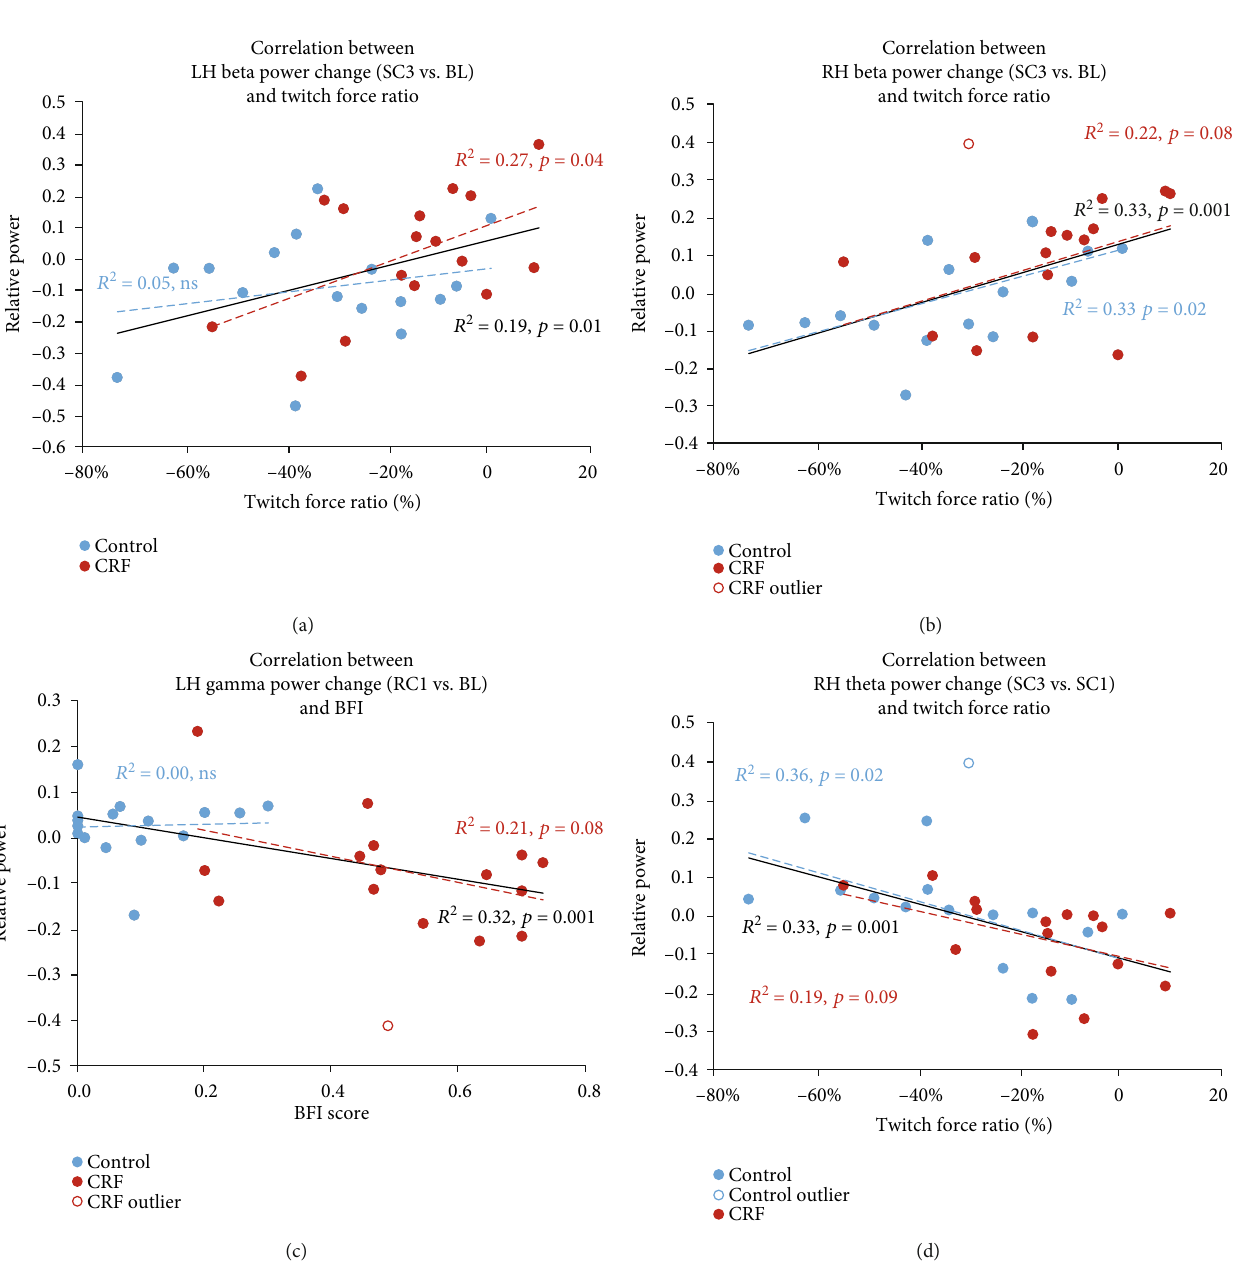
Figure 3: Linear correlation between (1) relative power change during the sustained contraction task (SC3 vs. SC1), at end of the task (SC3), or posttask (RC1) compared to baseline (BL) for CRF (red) or controls (blue); (2) twitch force ratio or BFI score. Linear fi ts are shown in black for the whole sample, blue for controls, and red for CRF. Outliers are shown in open circles; linear fi tting was done without the outliers. CRF: cancer-related fatigue; BFI: brief fatigue